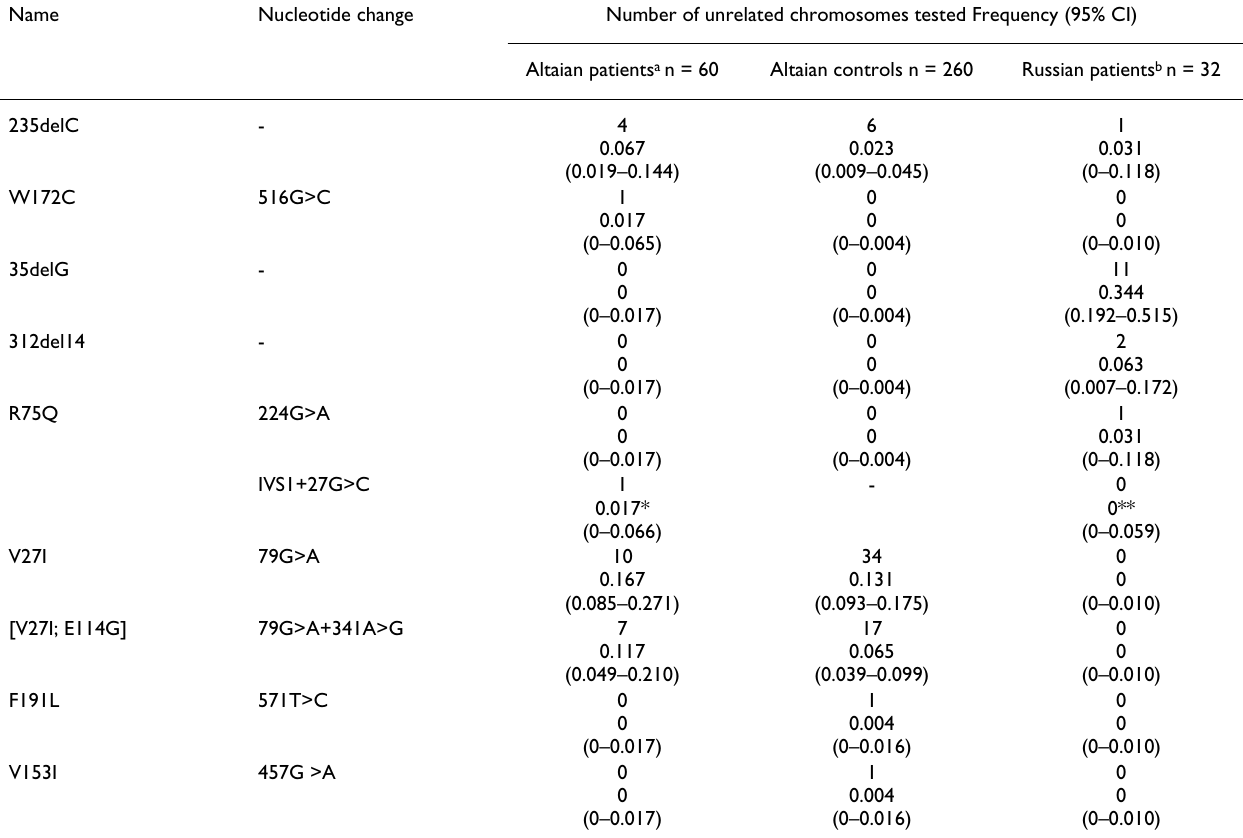
Table 2: Frequency of the GJB2 sequence variations among patients and Altaian